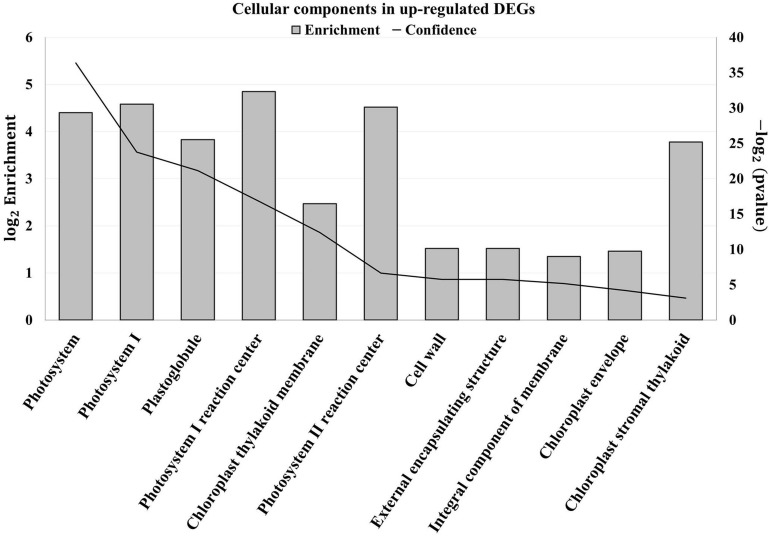
Enriched cellular components (Gene Ontology) in upregulated differentially expressed genes (DEGs) of tomato leaves after three sprayings with chitooligosaccharides–oligogalacturonides (COS-OGA; 62.5 mg/l; based on Plaza project, Dicot 4.5). Tomato leaves were harvested 24 h after the third treatment. Enriched cellular components (Gene Ontology) were identified based on hypergeometric test with Bonferroni correction (p values < 0.001). The left axis corresponds to the log2 enrichment fold. The right axis represents the −log2 (p value) represented on the chart by the confidence.